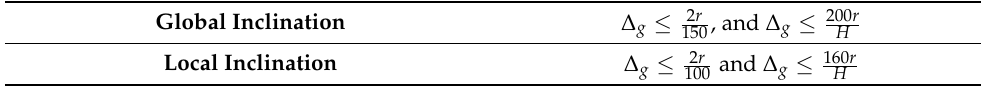
Table 4. The limitation of gap values of the PMT